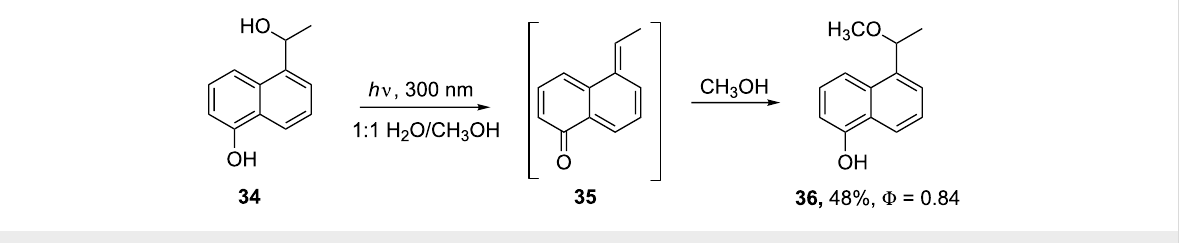
Scheme 8: Photodehydration and substitution of 5-(1-hydroxyethyl)-1-naphthol 34